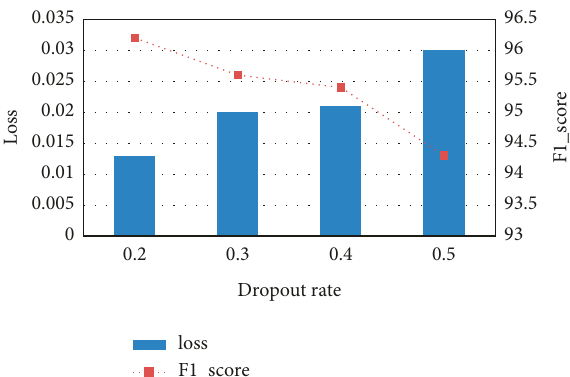
Figure 16: The performance of the model under different dropout